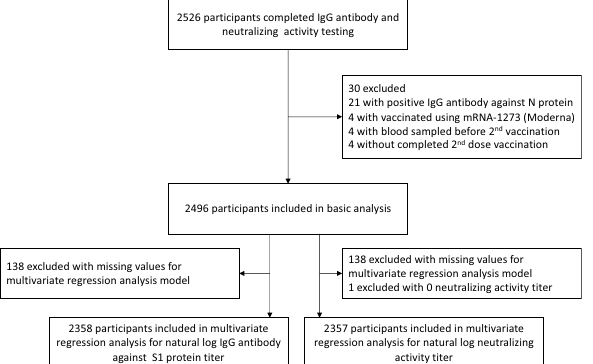
Figure 1. Requirement of participants. The participants were mainly recruited from rural Fukushima prefecture, including health care workers, frontline workers, administrative officers, general residents, and residents of long-term care